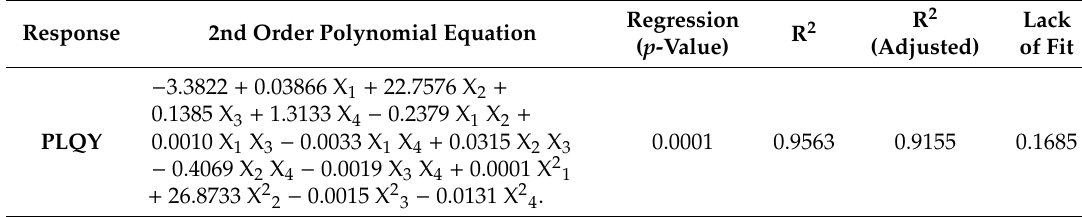
Table 4. The fitted quadratic model in terms of actual variables.